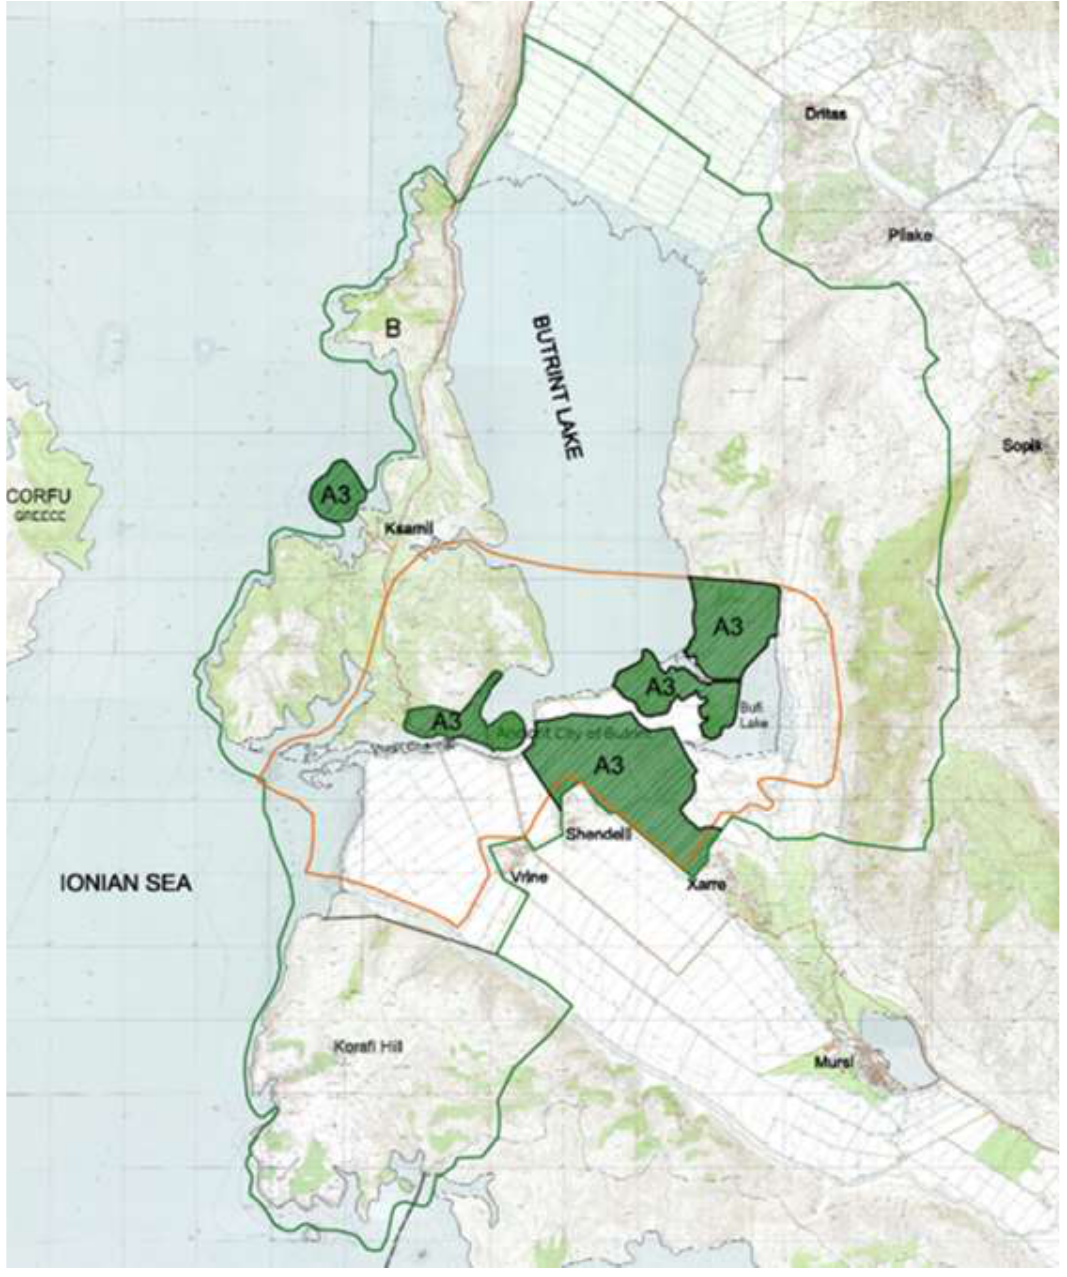
Figure 1: The map shows the current status of the protected areas in and around the World Heritage Site with regard to (a) the National Park (green), (b) the World Heritage Site Core Zone (brown) and (c) its component A3 Sub-Zone (hatched